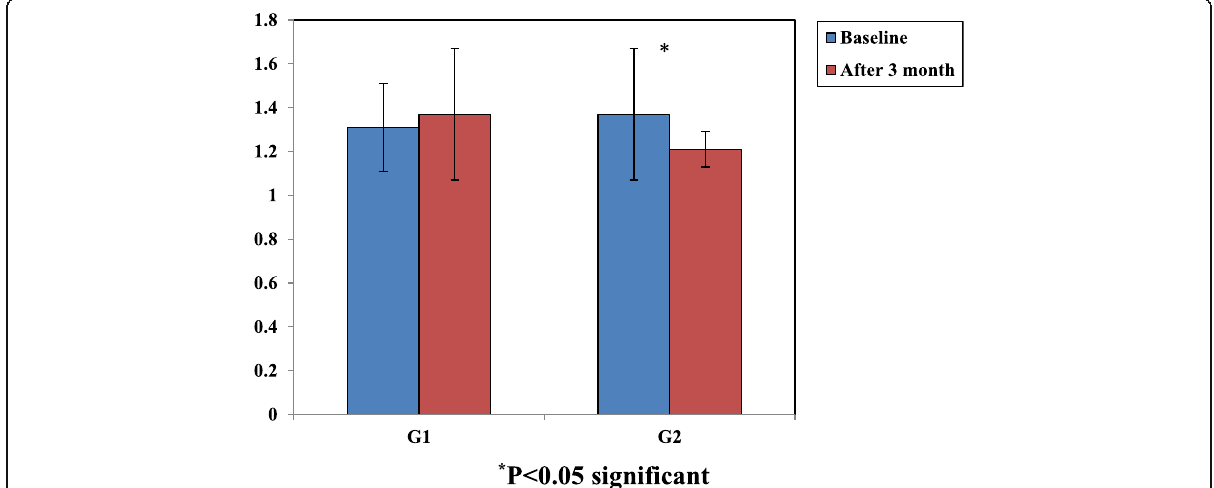
Fig. 1 Homeostatic model of assessment for insulin resistance in both groups. X-axis refers to the studied groups, Y-axis refers to the HOMA-IR value; G1, group 1; G2, group 2